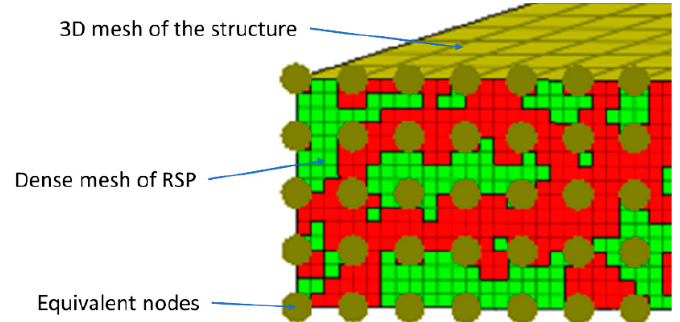
Figure 4. Graphical representation of RSP FE mesh and solid mesh of beam’s structure.